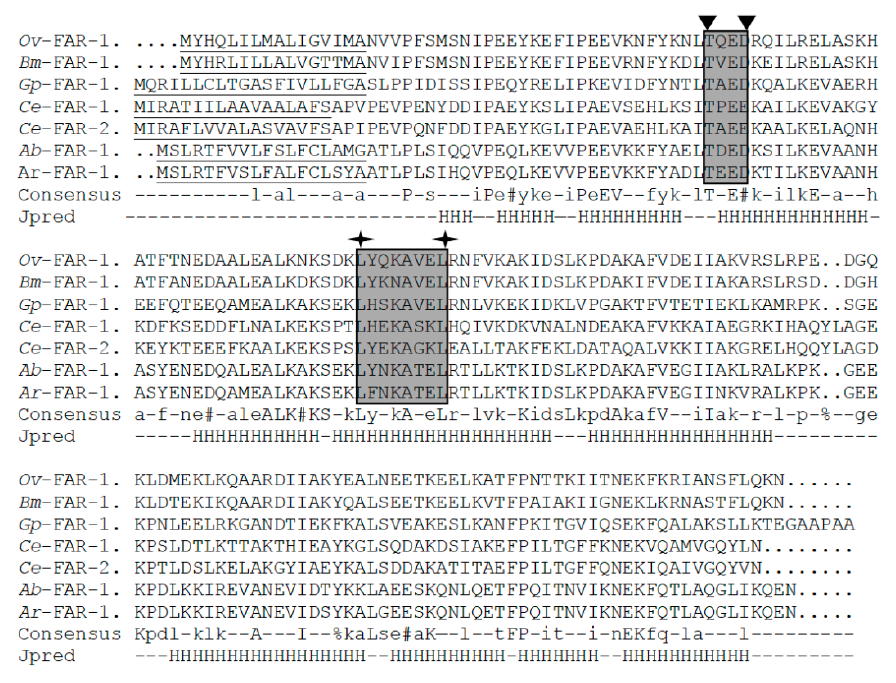
Figure 1. Multiple sequence alignment and structural predictions of the Aphelenchoides ritzemabosi Ar- FAR-1 protein and other FAR proteins from selected nematodes. Ov -FAR-1: Onchocerca volvulus FAR (Q25619); Bm -FAR-1: Brugia malayi FAR (Q93142); Gp -FAR-1: Globodera pallida FAR